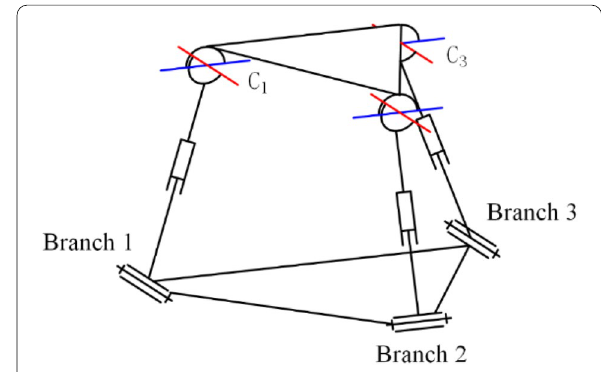
Figure 4 3-RPU PM that satisfy the requirement of Case